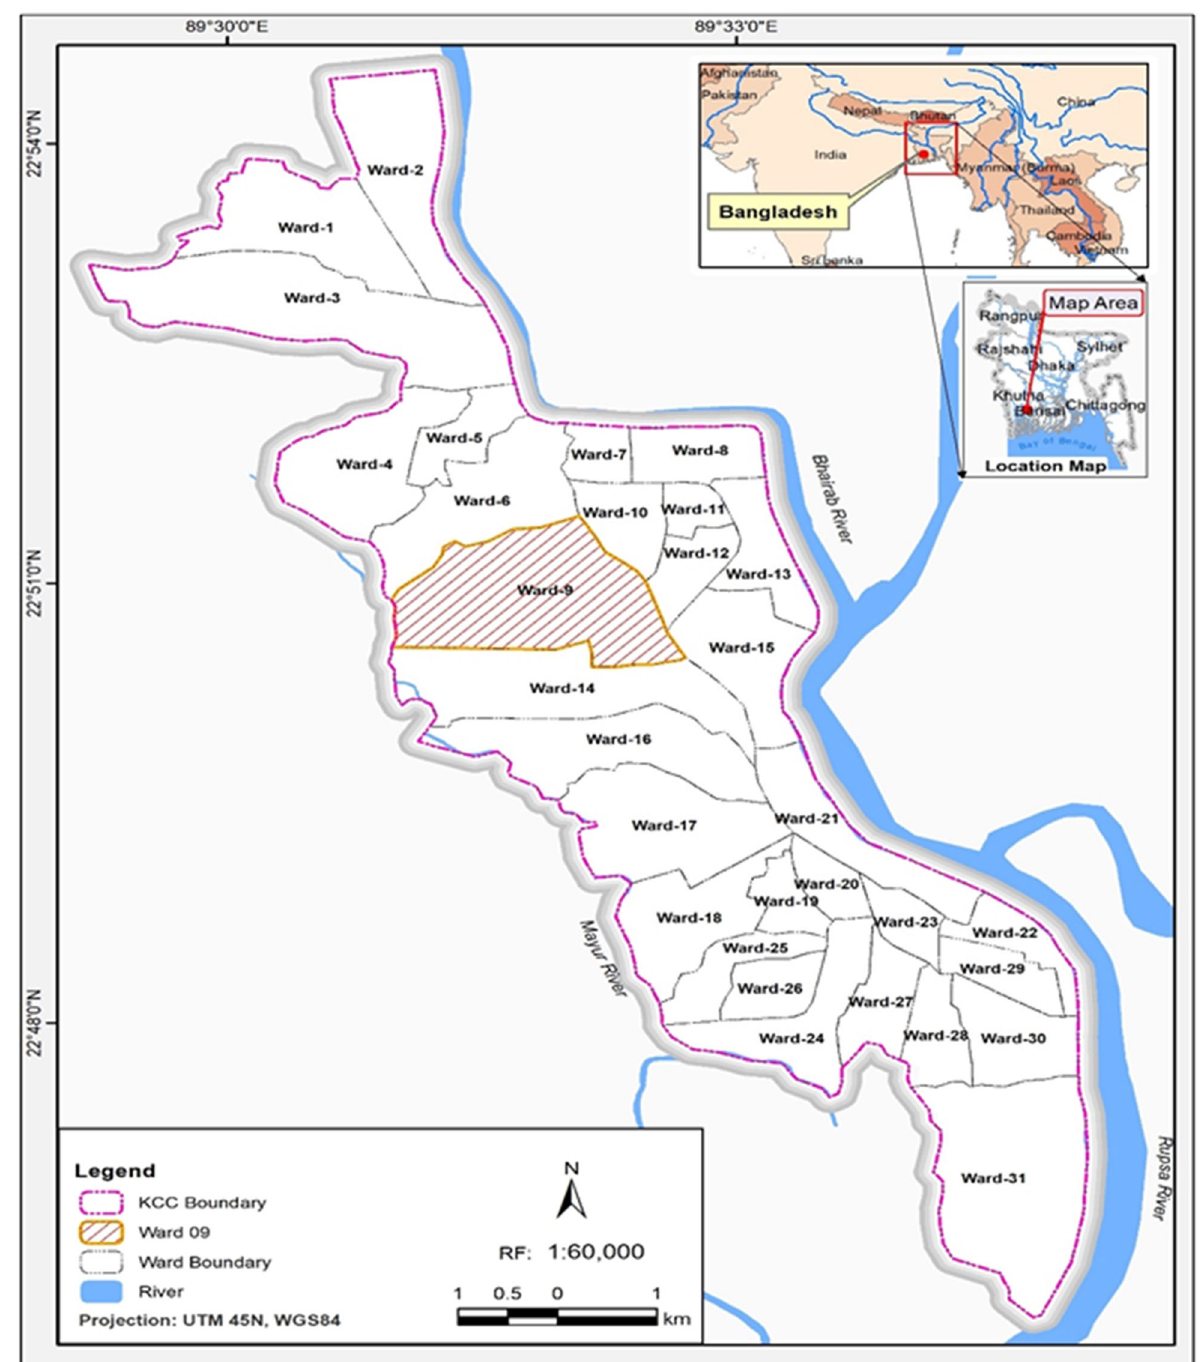
Fig. 2 Map of Khulna City Corporation. Map of Khulna City Corporation showing the location of Ward 9 in the study area and other speci fi c study